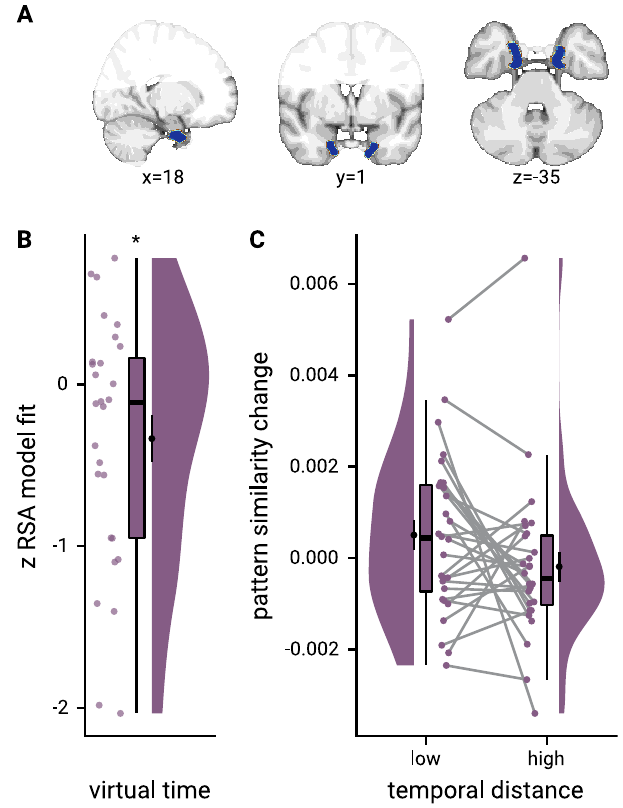
Fig. 6 The anterior-lateral entorhinal cortex uses a shared representational format for relations of events from the same and different sequences. A The anterior-lateral entorhinal cortex region of interest is displayed on the MNI template with voxels outside the fi eld of view shown in lighter shades of gray. Color code denotes probability of a voxel to be included based on participant-speci fi c masks (see Methods). B Z-values for participant-speci fi c RSA model fi ts show a negative relationship between pattern similarity change and virtual temporal distances when collapsing across all event pairs. C To illustrate the effect in B , raw pattern similarity change in the anterior-lateral entorhinal cortex was averaged for events separated by low and high temporal distances based on a median split. B , C Circles show data from n = 28 participants; boxplots show median and upper/lower quartile along with whiskers extending to most extreme data point within 1.5 interquartile ranges above/below the upper/lower quartile; black circle with error bars corresponds to mean ± S.E.M.; distributions show probability density function of data points. Source data are provided as a Source Data fi le. * p <